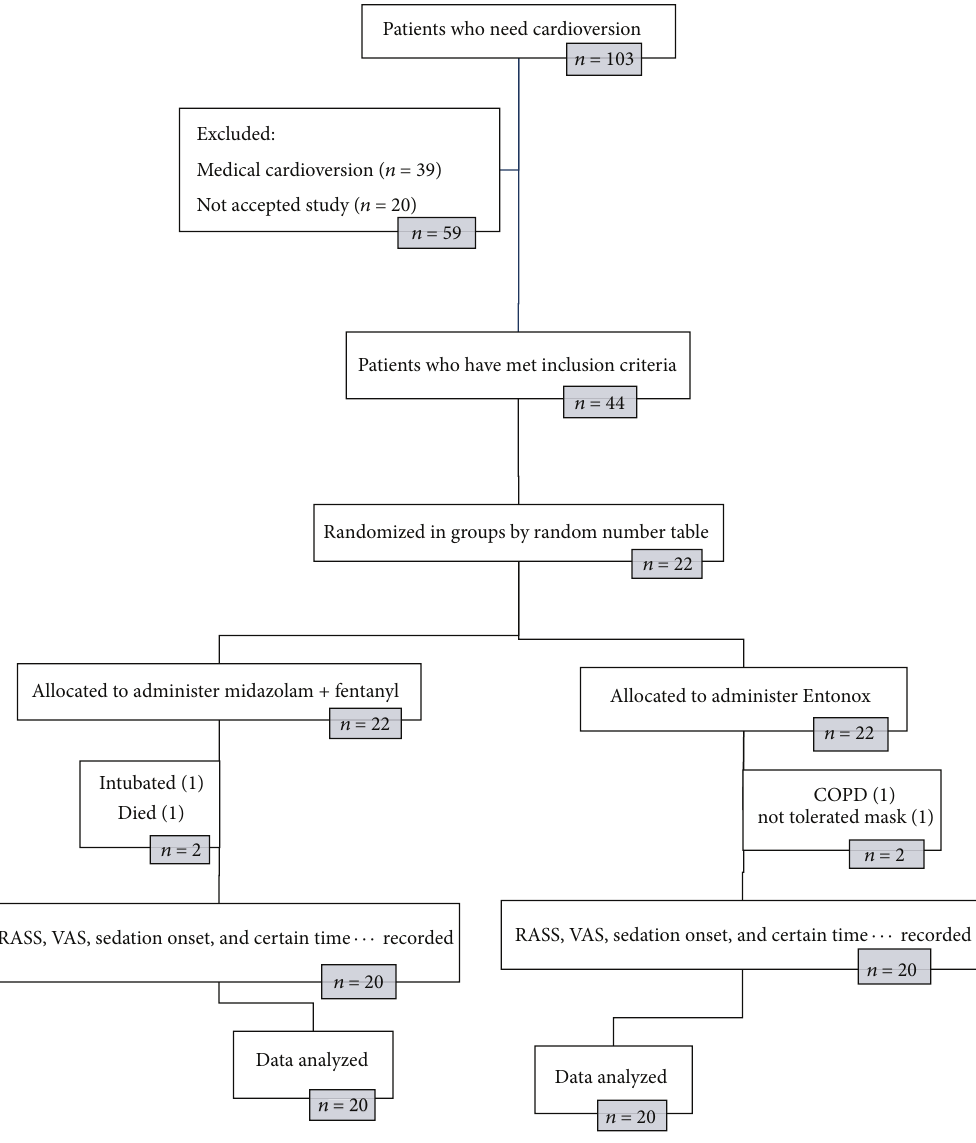
Figure 2: Randomized controlled trial flowchart of patients’ recruitment is